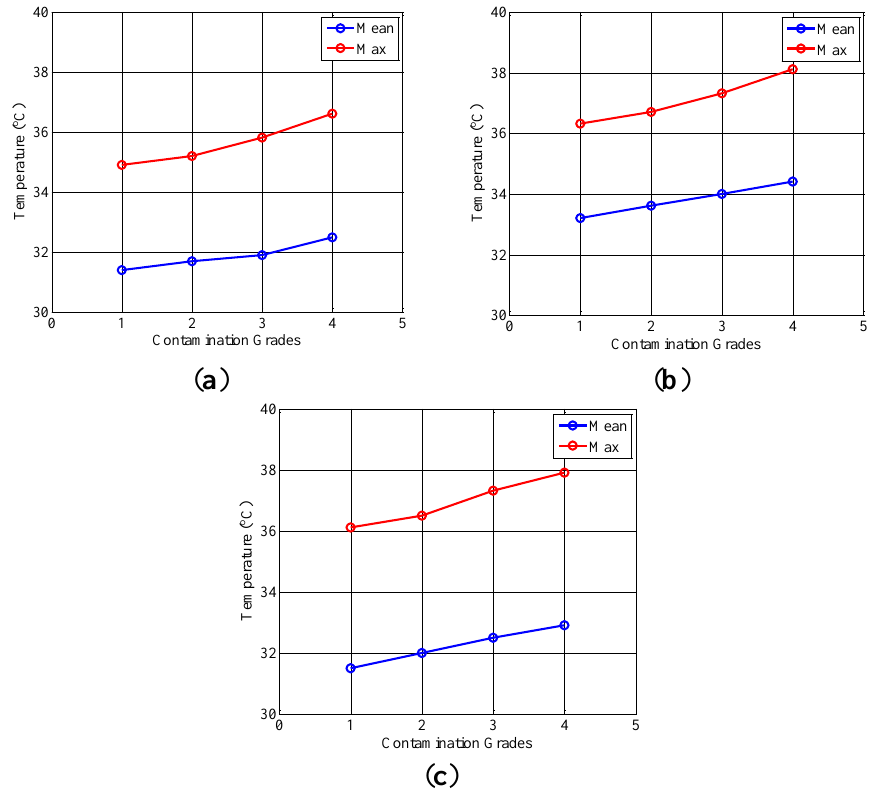
Figure 9. Distribution curves of mean temperature and max temperature. ( a ) RH = 80%, ambient temperature is 29 °C; ( b ) RH = 85%, ambient temperature is 30.2 °C; ( c ) RH = 90%, ambient temperature is 28.3